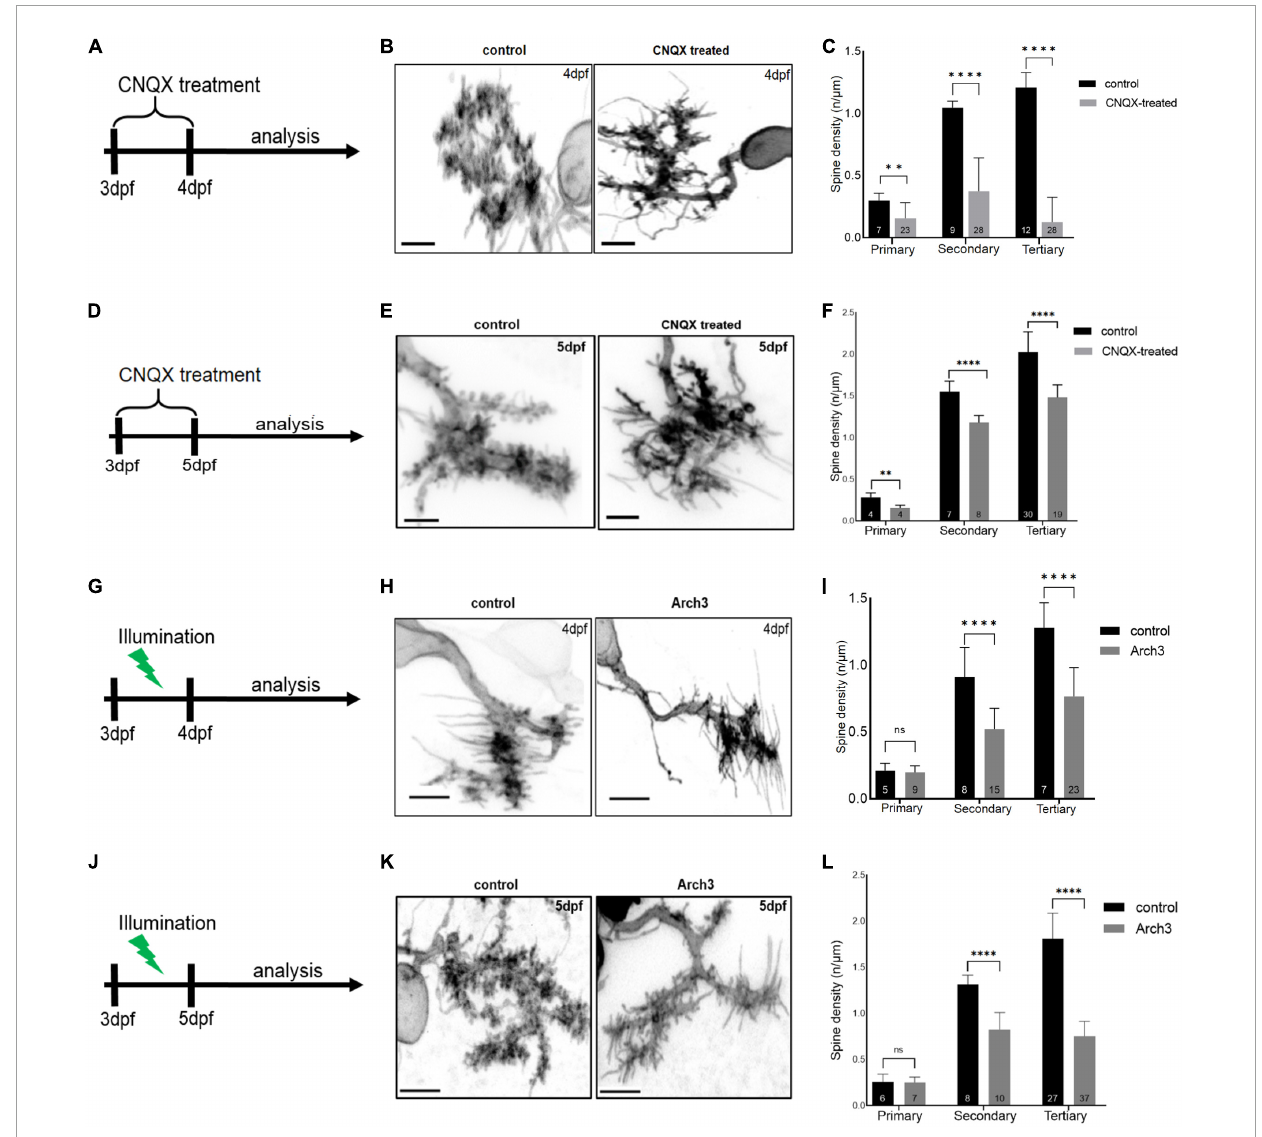
FIGURE3 Inhibiting Purkinje cell (PC) neuronal activity reduces PC spine density. Schematic drawing illustrating the scheme of 6-cyano-7-nitroquinoxaline-2, 3-dione (CNQX) treatment from 3 dpf to analysis on 4 dpf (A) and on 5 dpf (D) . Maximum intensity projection of untreated and CNQX treated PC at 4 dpf (B) and 5 dpf (E) . Scale bar: 5 µ m. Representation of spine density on primary, secondary and tertiary branches of CNQX treated PCs (gray) vs. controls (black) at 4 dpf (C) and at 5 dpf (F) . Schematic drawing illustrating the start of pulsed illumination of 517 nm monochromatic light until the confocal microscopy analysis of Arch3 and non-Arch3 expressing larvae at 4 dpf (G) and 5 dpf (J) . Maximum intensity projection of PC at 4 dpf (H) and 5 dpf (K) from Arch3 larvae and non-Arch3 expressing larvae, respectively. Scale bar: 5 µ m. Graph showing PC spine density quantification